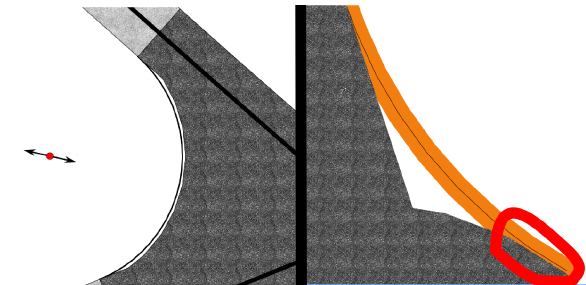
Figure 17: Example of a precision issue. Left, we approximate arcs with segments, which introduces errors. Right, the error was sufficient to incorrectly union the intersection